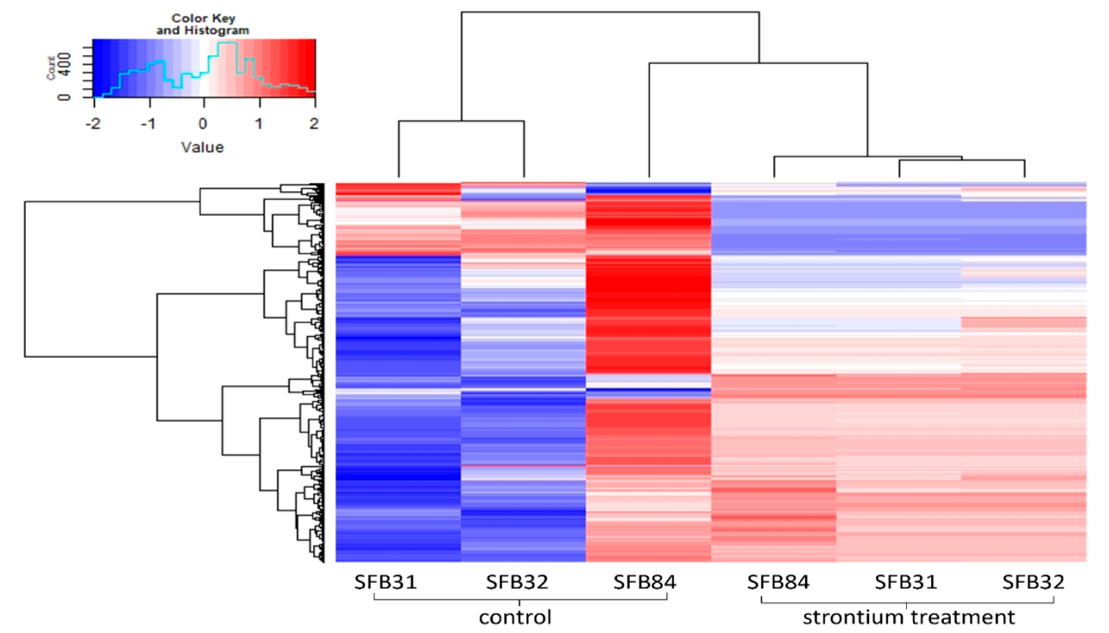
Figure 7. Heatmap depicting the metabolomes of guttation droplets of the three Aspergillus sp. strains with and without Sr.